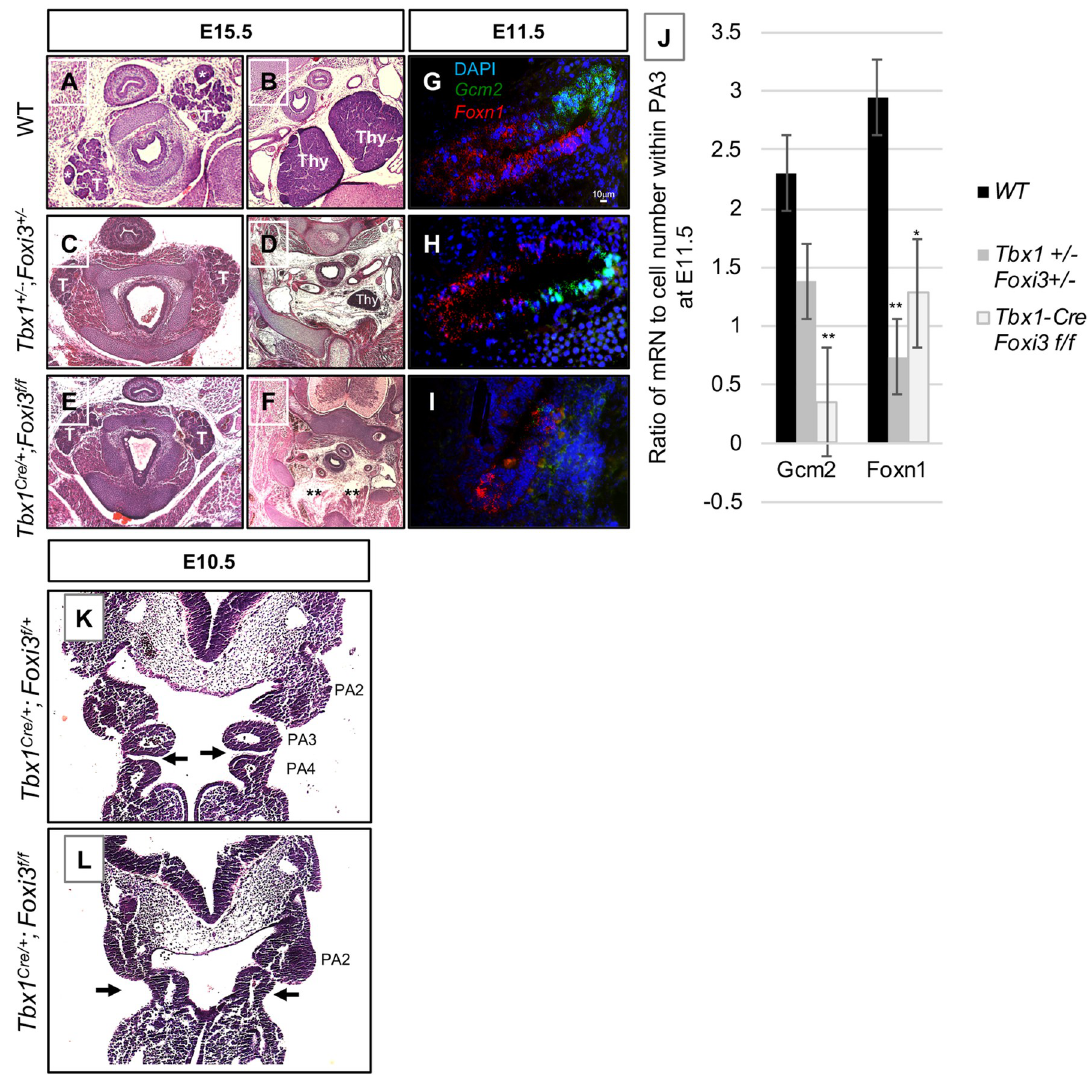
Fig 2. Thymus and parathyroid gland defects in Tbx1 +/- ;Foxi3 +/- and Tbx1 Cre/+ ;Foxi3 f/f embryos. (A-F) Transverse histology sections stained with H&E of WT (A-B), Tbx1 +/- ;Foxi3 +/- (C-D) and Tbx1 Cre/+ ;Foxi3 f/f (E-F) embryos at E15.5. Abbreviations: thyroid (T) and thymus (Thy). Asterisks in A indicate parathyroid glands. Asterisks in F indicate absent thymus glands. Numbers include: WT, n = 16; Tbx1 +/- ;Foxi3 +/- , n = 13; Tbx1 Cre/+ ;Foxi3 f/f , n = 14. Normal parathyroid glands are located adjacent to thyroid glands (A) as compared to when they are not present adjacent to the thyroid glands in mutant embryos (C, E). Thymus glands are located at the branchpoint between the innominate and right carotid artery (B) but are more rostrally located and smaller (D) or absent (E) in mutant embryos. (G-I) RNAscope in situ hybridization with mRNA probes for Gcm2 (green) and Foxn1 (red) probes on sagittal sections in WT (G), Tbx1 +/- ;Foxi3 +/- (H) and Tbx1 Cre/+ ;Foxi3 f/f (I) embryos at E11.5. Gcm2 marks parathyroid gland precursor cells and Foxn1 marks thymus gland precursor cells; n = 3 for each genotype. (J) Quantification of RNAscope experiments. Number of mRNA signal dots was quantified in proportion to number of cells present in each tissue section. P-values were determined using the t-test. Two stars indicate a P-value < 0.005 and one star indicates a P-value < 0.05. (K-L) H&E coronal histology sections of Tbx1 Cre/+ ;Foxi3 f/+ (K), and Tbx1 Cre/+ ; Foxi3 f/f (L) embryos at E10.5. Arrows indicate the third pharyngeal pouch and morphology defects. Third pouch is absent in L. Tbx1 Cre/+ ;Foxi3 f/+ , n = 6 and Tbx1 Cre/+ ;Foxi3 f/f , n = 8. double heterozygous embryos, but no other malformations were detected (S1I–S1M Fig). Again, the phenotype at E15.5 is relatively mild in comparison to either null mutant, in which the organs were completely absent. To gain more insights into the basis of the observed defects, we examined where Tbx1 and Foxi3 are co-expressed.